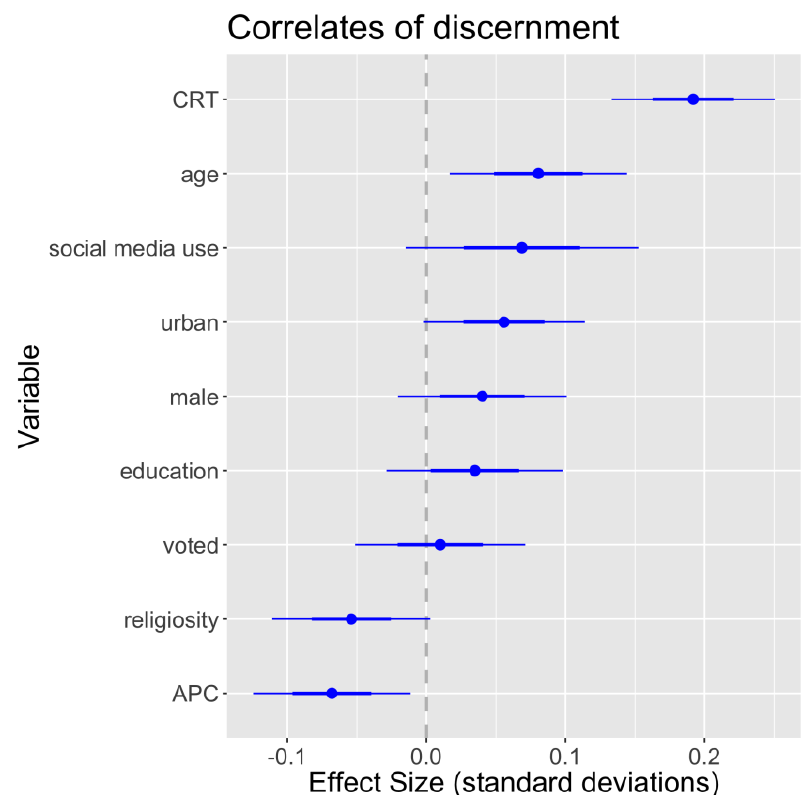
Figure 3. Coefficients predicting discernment (the number out of 10 headlines each respondent correctly identified as true or false). All variables have been standardized, mean-centered and scaled by standard deviation for comparability. Thin lines indicate 95% confidence intervals (CIs), thick lines indicate 90% CIs. Right of the dotted zero line (i.e., positive values) indicates a positive correlation with discernment and decreased susceptibility to